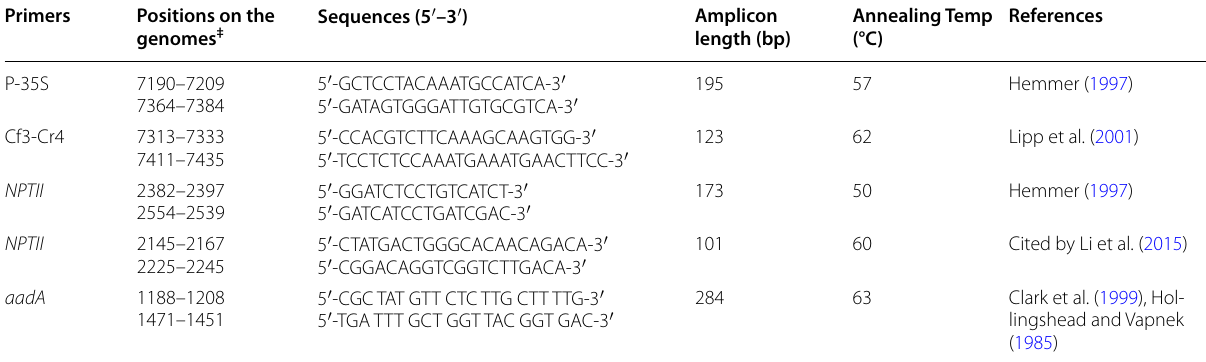
‡ Positions of the primers are relevant to: Cauliflower mosaic virus genome (accession no. emb|V00141.1|), NPTII gene (accession no. AF080390.1), and aadA gene (accession no.MH973510.1) Table 2 Blood sampling codes matrix Animals’